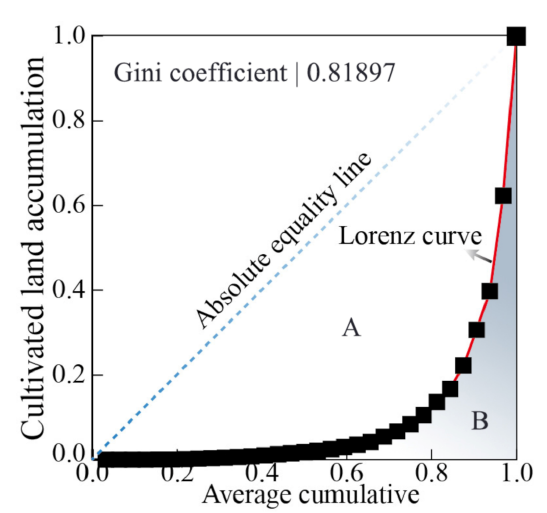
Figure 3. Lorentz curve of cultivated land geomorphic